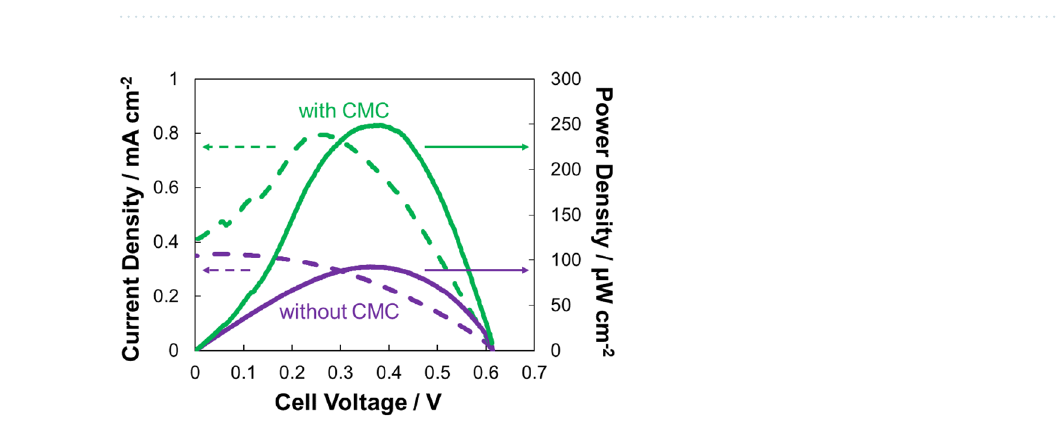
Figure 3. Electrochemical evaluation of ( a ) biocathodes, and ( b ) bioanodes fabricated using MgOC inks with and without CMC. 1 M phosphate buffer, pH 7.0; 0.3 V vs Ag/AgCl/sat. KCl; room temperature. ( b ) 100 mM lactate. ( a ) BOD; ( b ) LOx, 1,2-NQ. Green: with CMC; violet: without CMC.